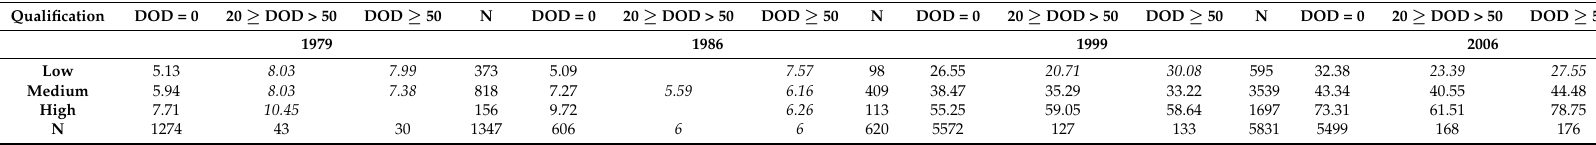
Table 2. Development of computer use by degree of disability (DOD), 1979–2006 (absolute terms and in percent).